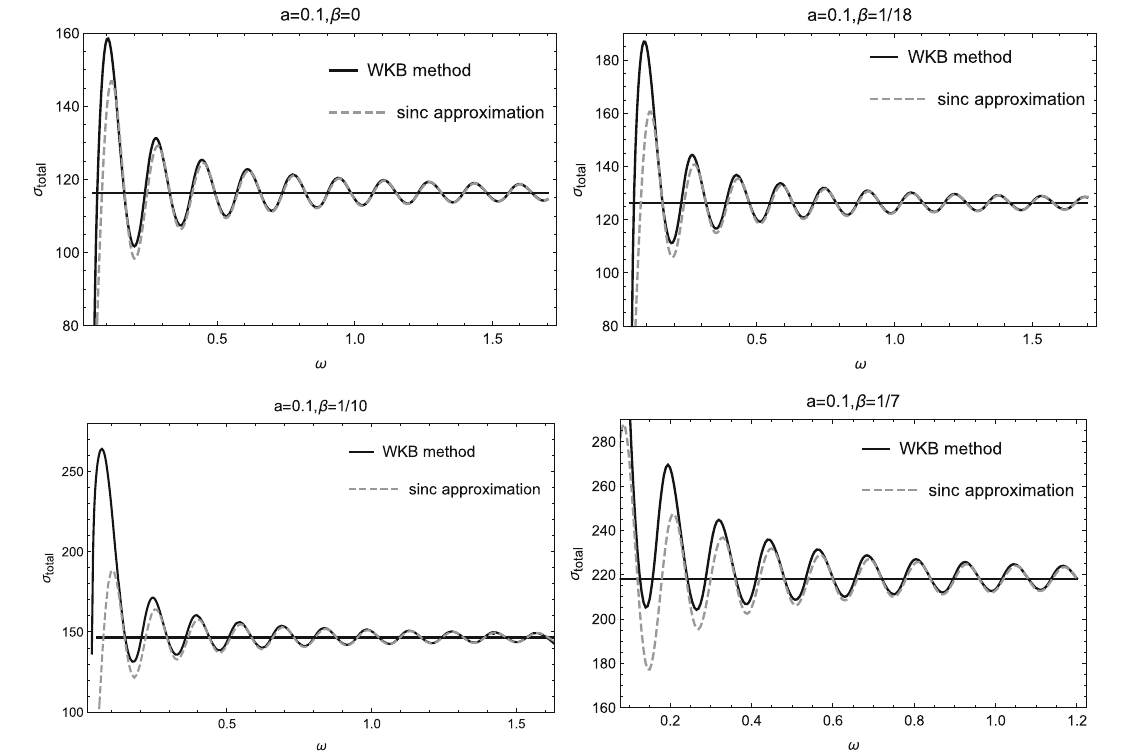
Fig. 5 For β > 0 and M = 1, the total absorption cross section for the variable β at a = 0 . 1, and β = 0 recovers to the Einstein gravity